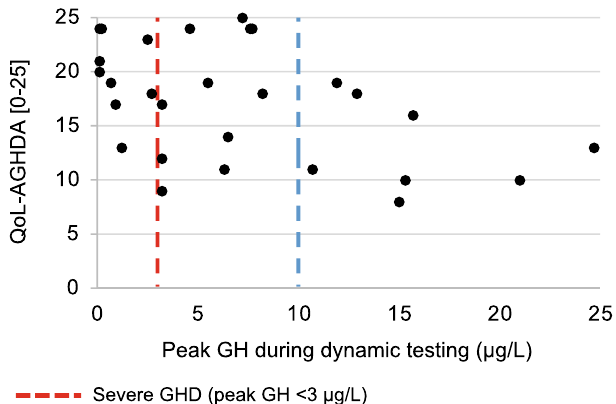
Figure 4. Quality of life assessment and dynamic testing results. Qol-AGHDA scores (n = 28) were correlated with peak GH during dynamic testing, r(26) = − 0.454, p = 0.015. GH growth hormone, GHD growth hormone deficiency, GHI growth hormone insufficiency, QoL-AGHDA Quality of Life Assessment of Growth Hormone Deficiency in Adults.